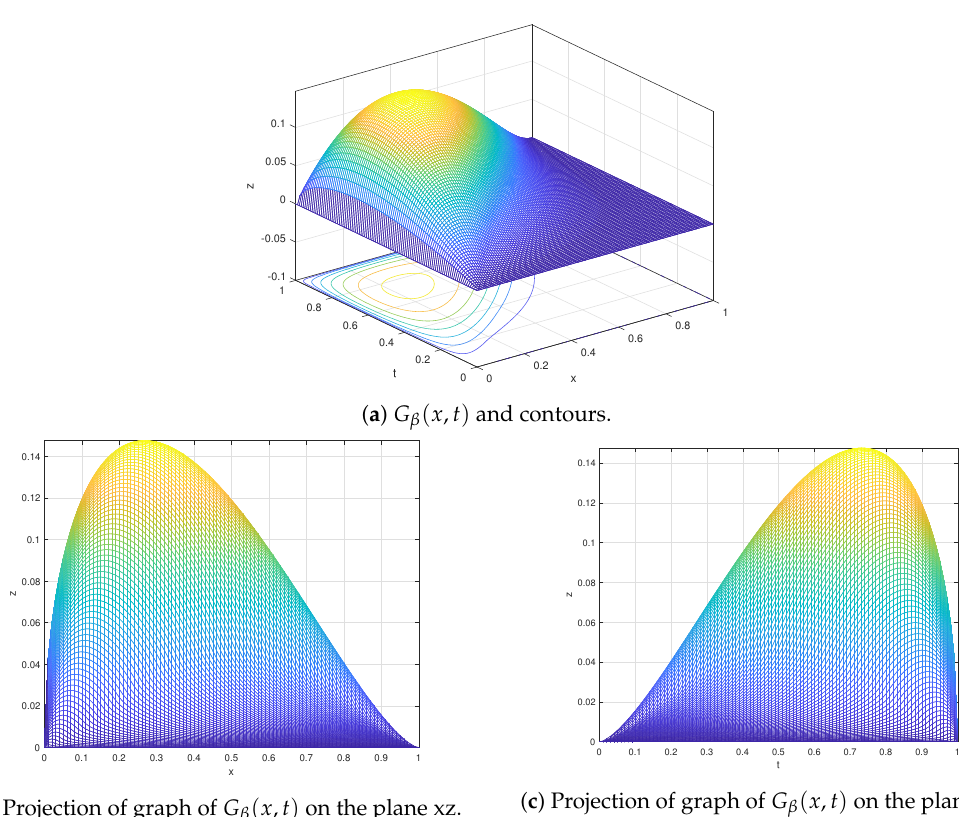
( b ) Projection of graph of G β ( x , t ) on the plane xz. ( c ) Projection of graph of G β ( x , t ) on the plane tz. Figure 2. The Green function for β = 5/2.